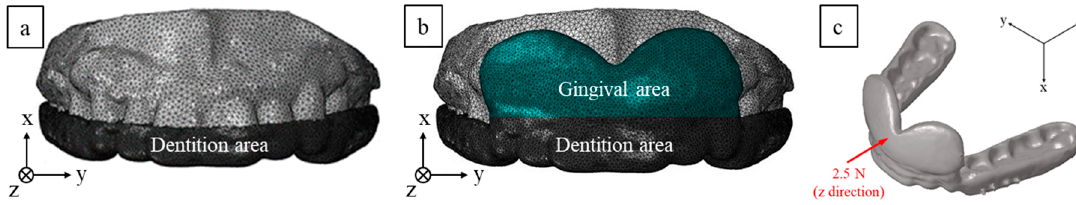
Figure 2. Mechanism of the proposed MAD: ( a ) initial state and ( b ) mechanism blocking protrusion.